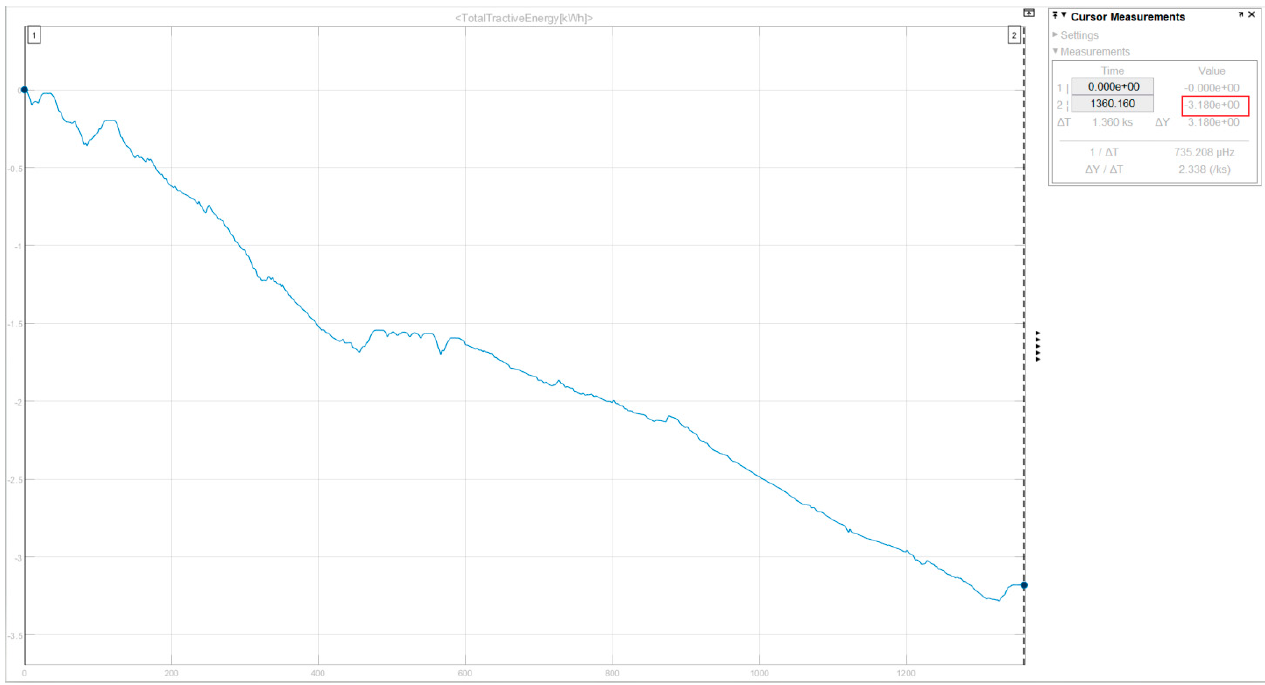
Figure 27. Vehicle tractive energy over time.